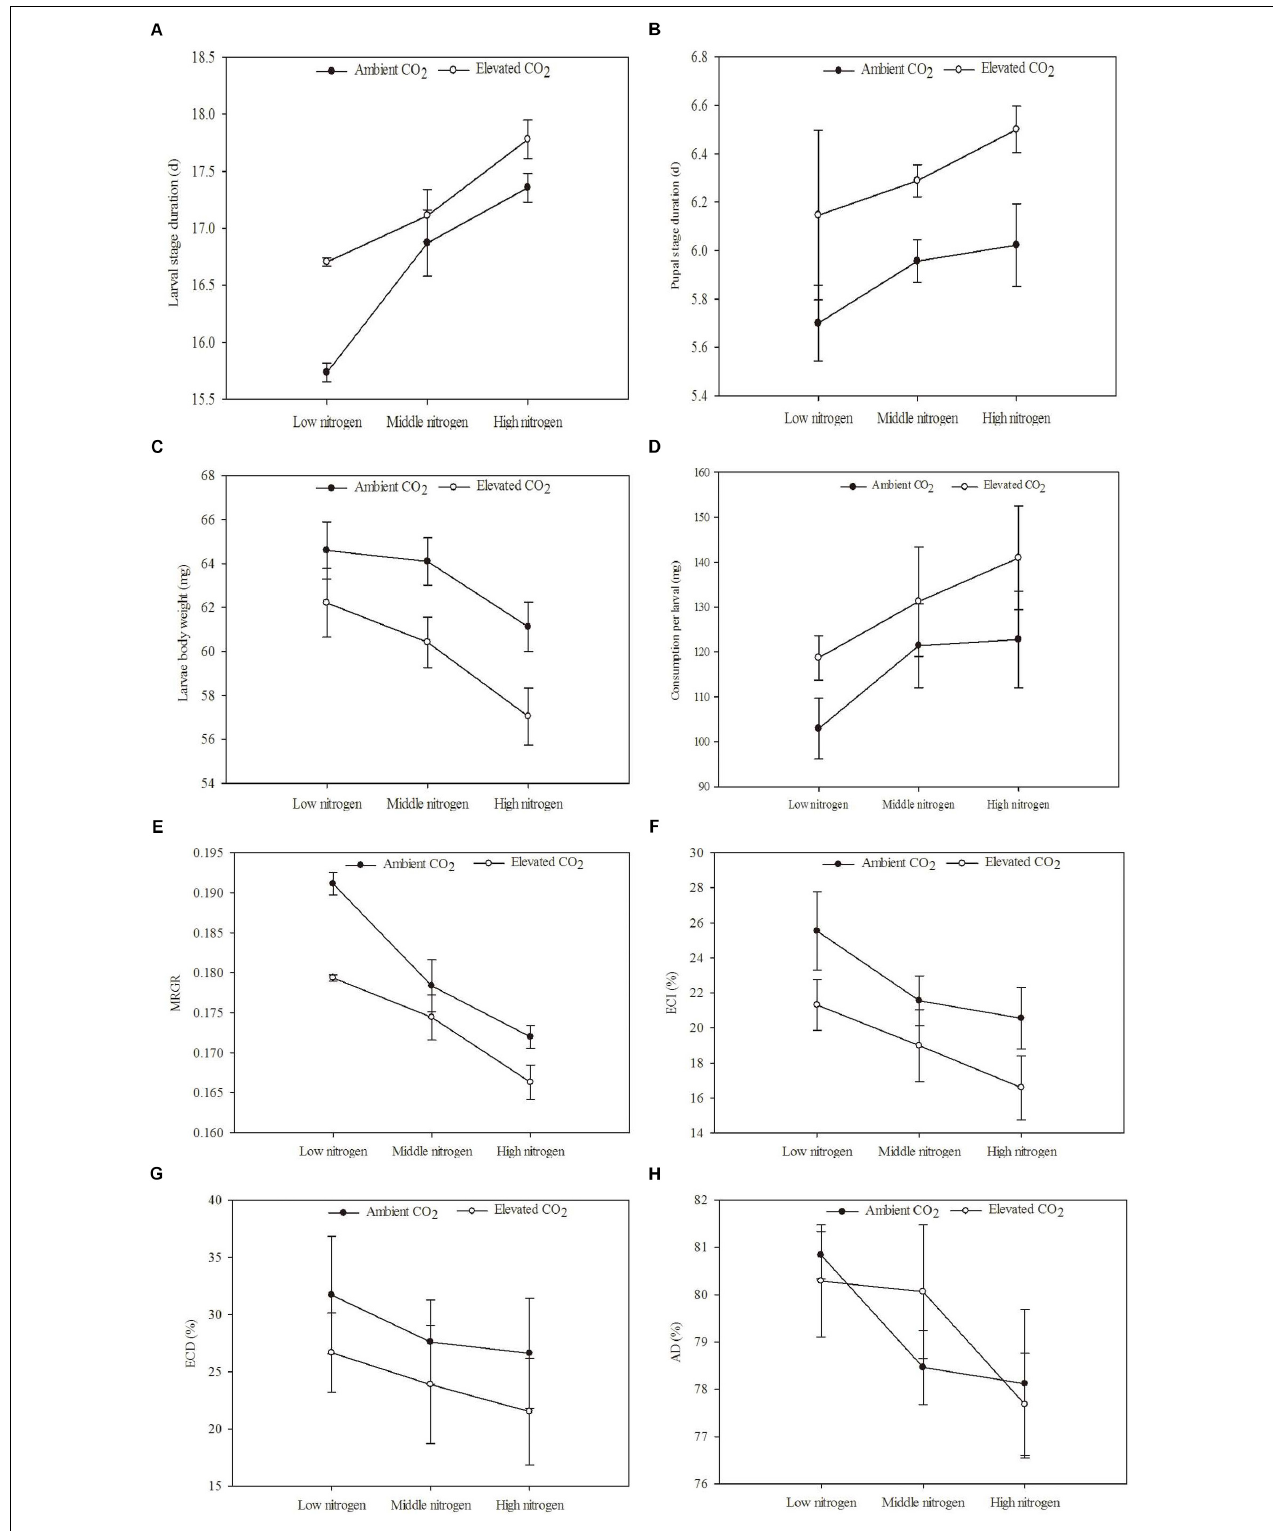
FIGURE 5 | Development and digestibility of O. furnacalis feeding on mazie grown under different levels of CO 2 and nitrogen fertilization conditions (mean ± SE, n = 3). (A) Larvae stage duration, (B) pupal stage duration, (C) larvae body mass, (D) food consumption, (E) mean relative growth rate (MRGR), (F) efficiency of conversion of ingested food (ECI), (G) efficiency of conversion of digested food (ECD), and (H) approximate digestibility (AD).